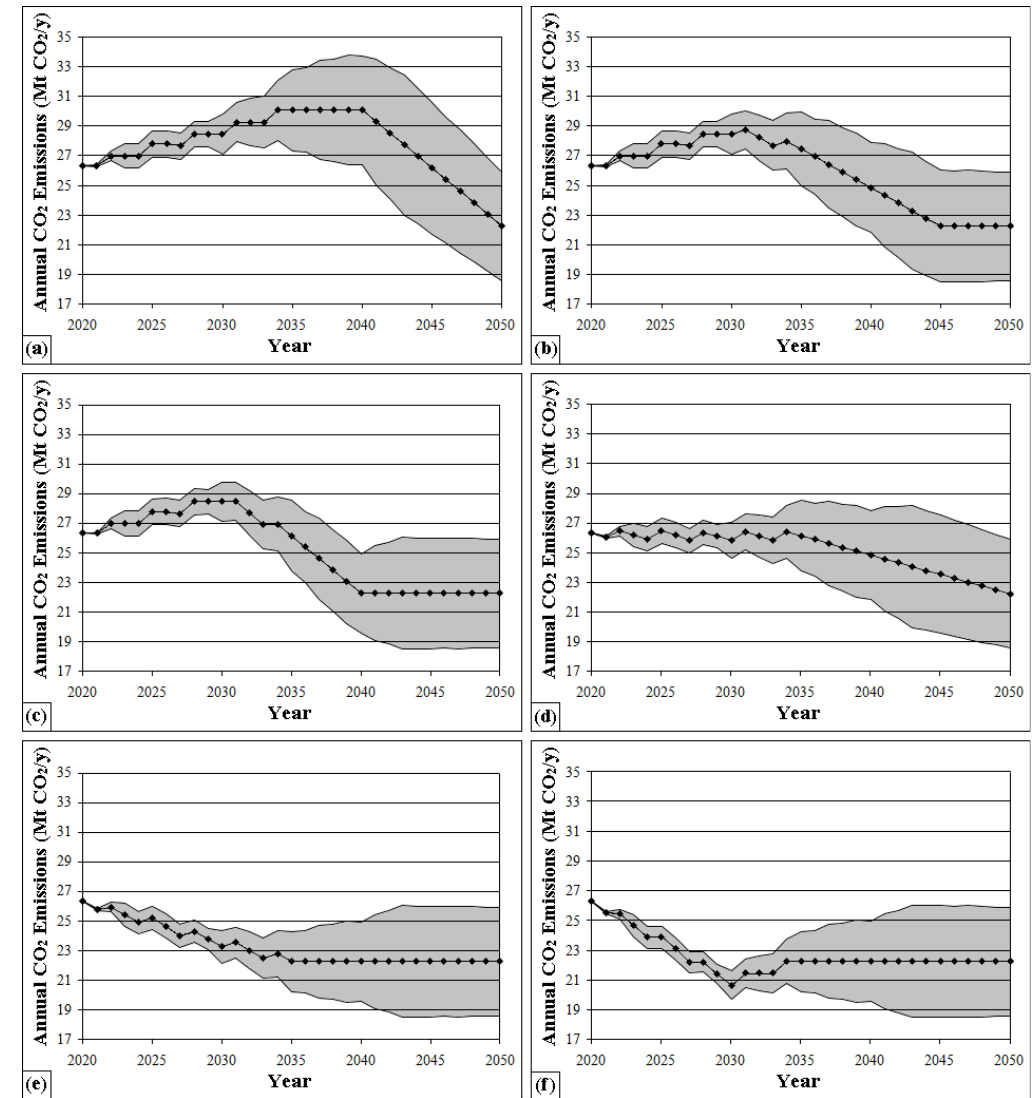
Figure A1. Projections of annual CO 2 emissions from the Serbian electricity generation by the end of 2050, taking into account national targets relating to the independence of the electricity supply, that is, Scenario 1, namely: ( a ) Sub-scenario 1-1; ( b ) Sub-scenario 1-2; ( c ) Sub-scenario 1-3; ( d ) Sub-scenario 1-4; ( e ) Sub-scenario 1-5; and ( f ) Sub-scenario 1-6.